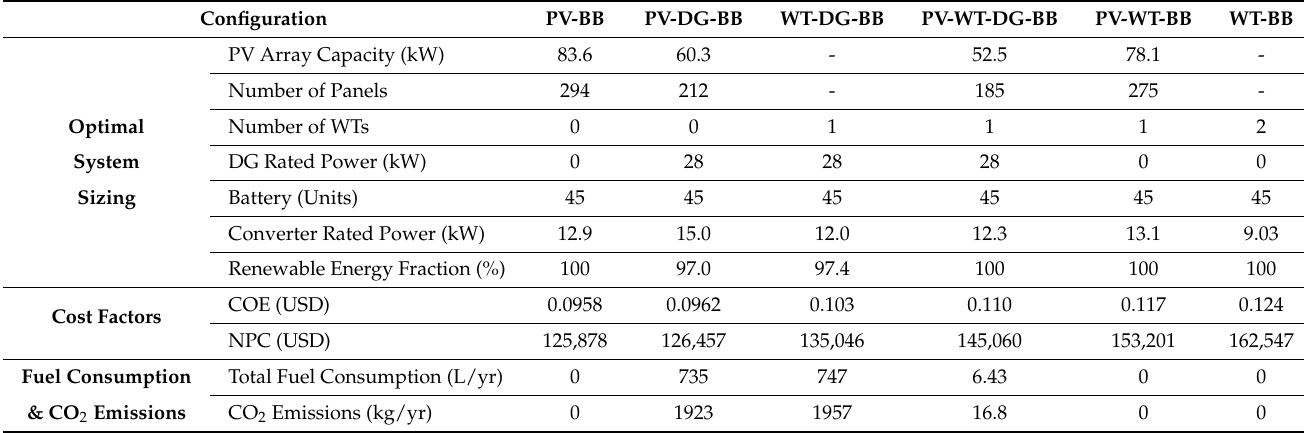
Table 17. Simulation Results for Wafra Cell Site—Case 3.